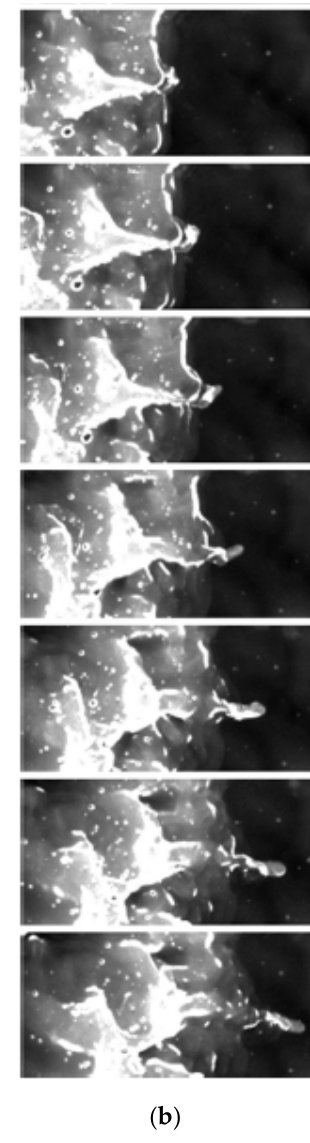
Figure 13. Bag break-up ( a ) and ligament break-up ( b ) imaged in the x - y plane by BBLIF technique. Gas-sheared liquid film in a horizontal rectangular duct [46]. Image size is 20 mm × 13 mm ( a ) and 20 mm × 10 mm ( b ). Time step is 0.5 ms.